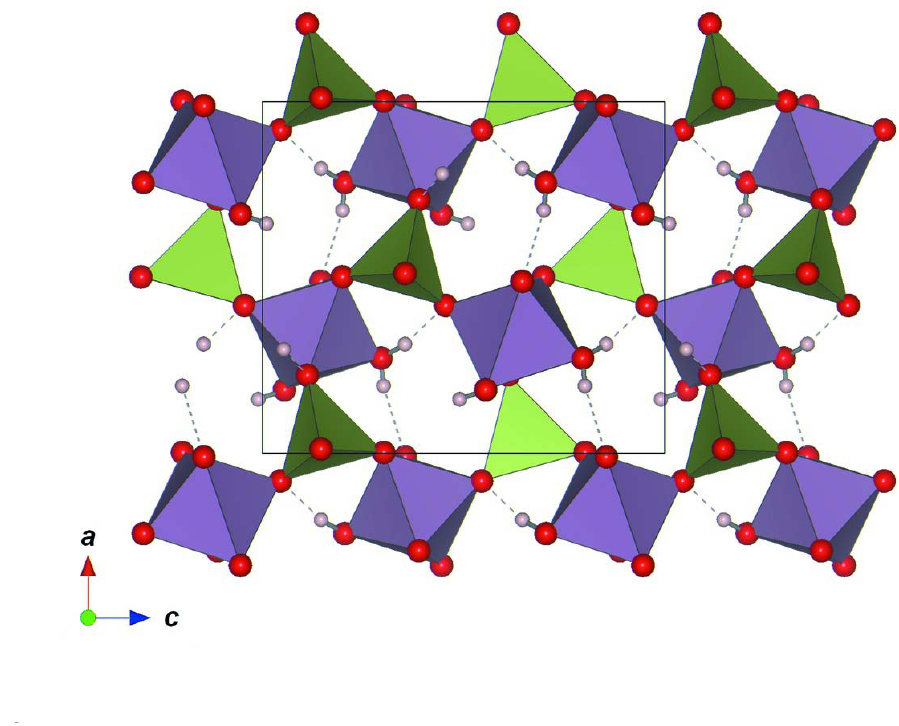
Figure 2 The crystal structure of mansfieldite, viewed along the b axis. The unit cell is outlined and the hydrogen bonds are represented by dashed